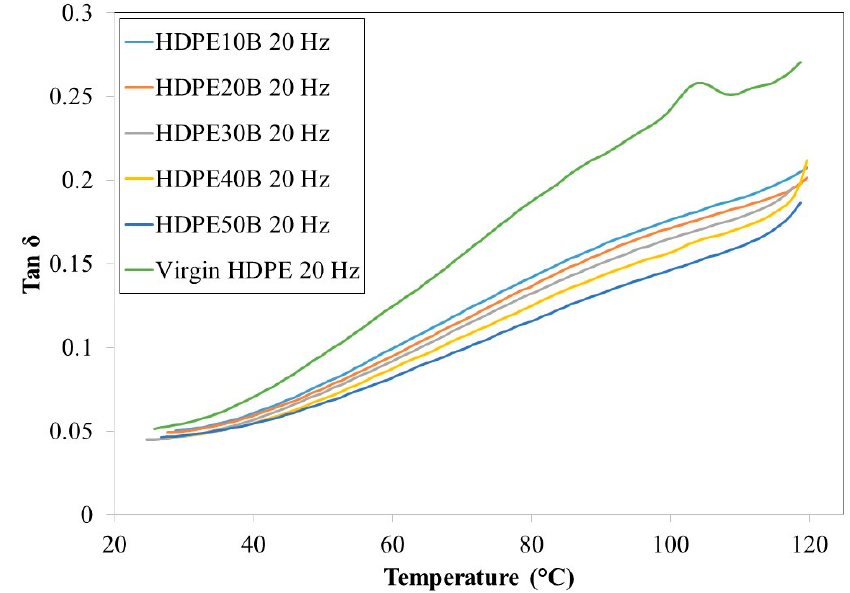
Figure 11. Temperature dependency of the damping ratio tan ό of HDPE/birch fiber com- posites at a stress frequency of 20 Hz.